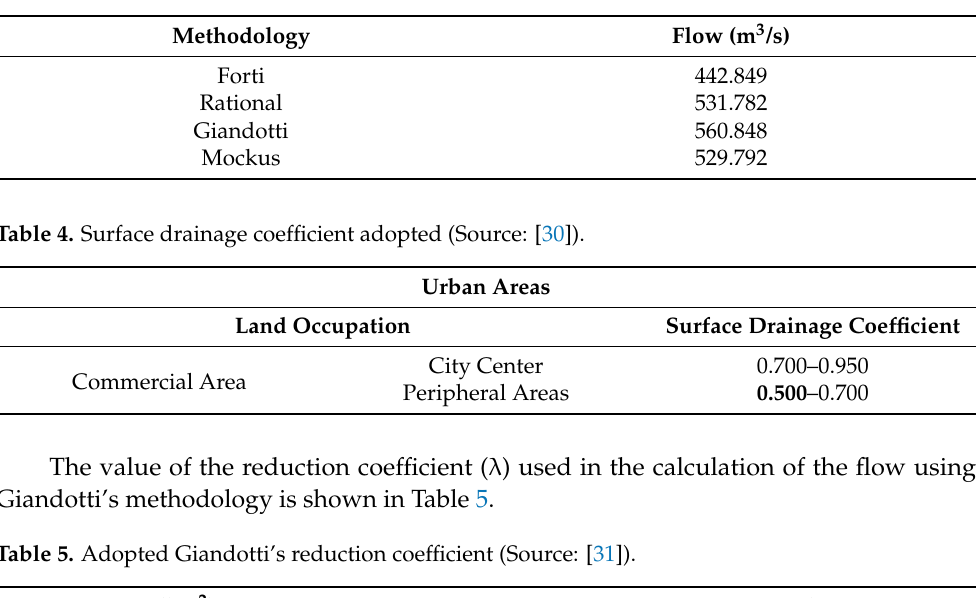
Table 3. Peak flow rate.